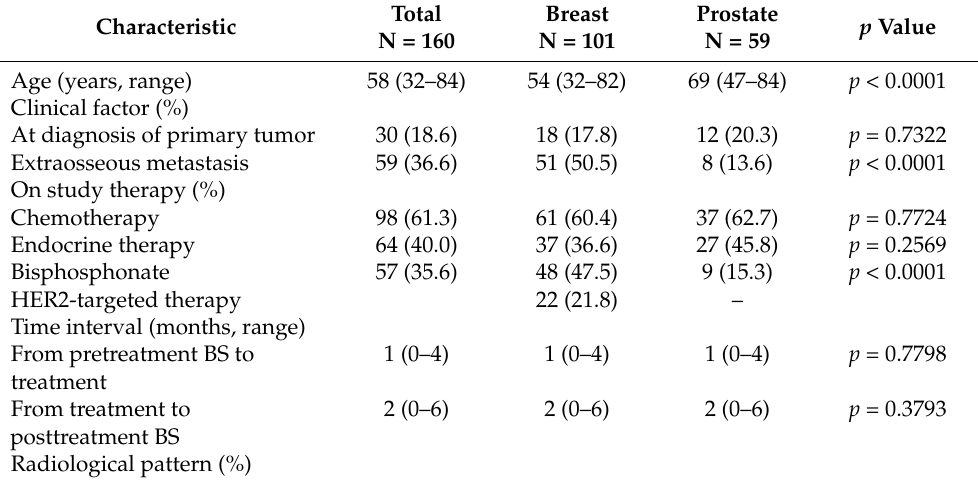
Table 1. Patient